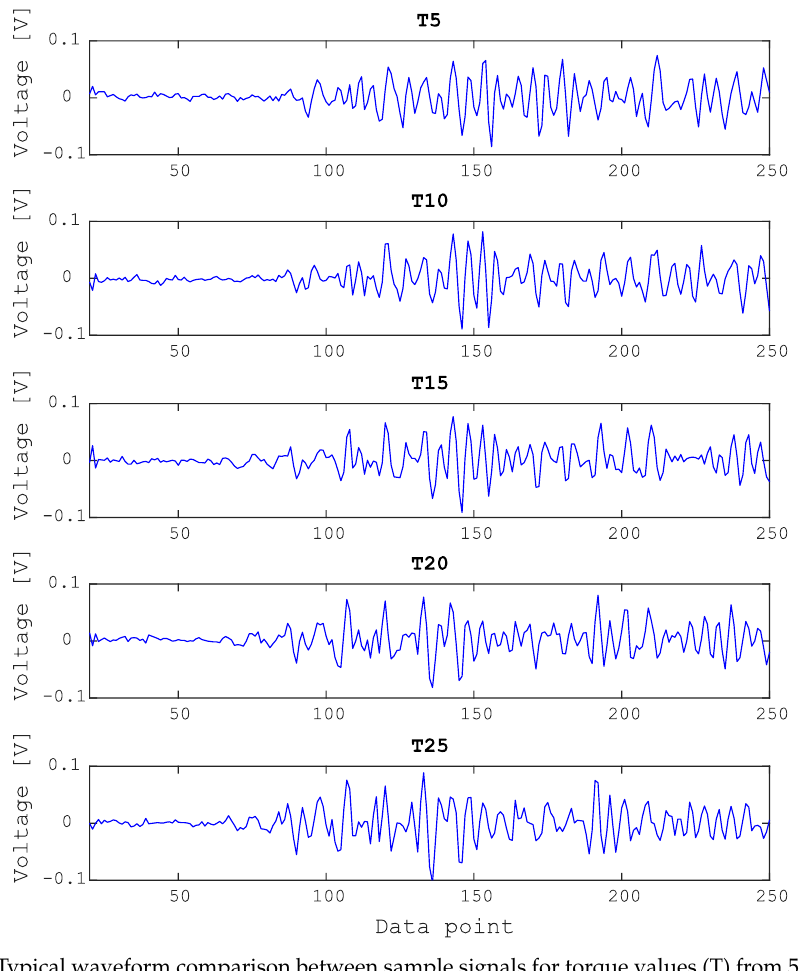
Figure 9. Typical waveform comparison between sample signals for torque values (T) from 5 to 25 Nm.